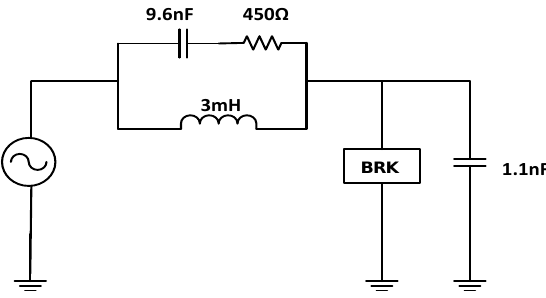
Figure 6. Transient model performance during disruption of a short-line fault using the SF 6 test circuit breaker (BRK). breaker